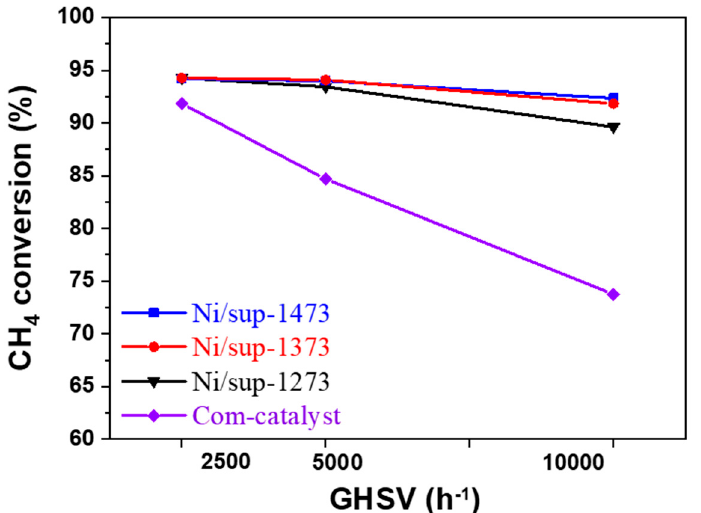
Figure 8. The methane conversion of Com-catalyst (purple line), Ni/sup-1273 (black line), Ni/sup-1373 (red line) and Ni/sup-1473 (blue line) according to space velocity.